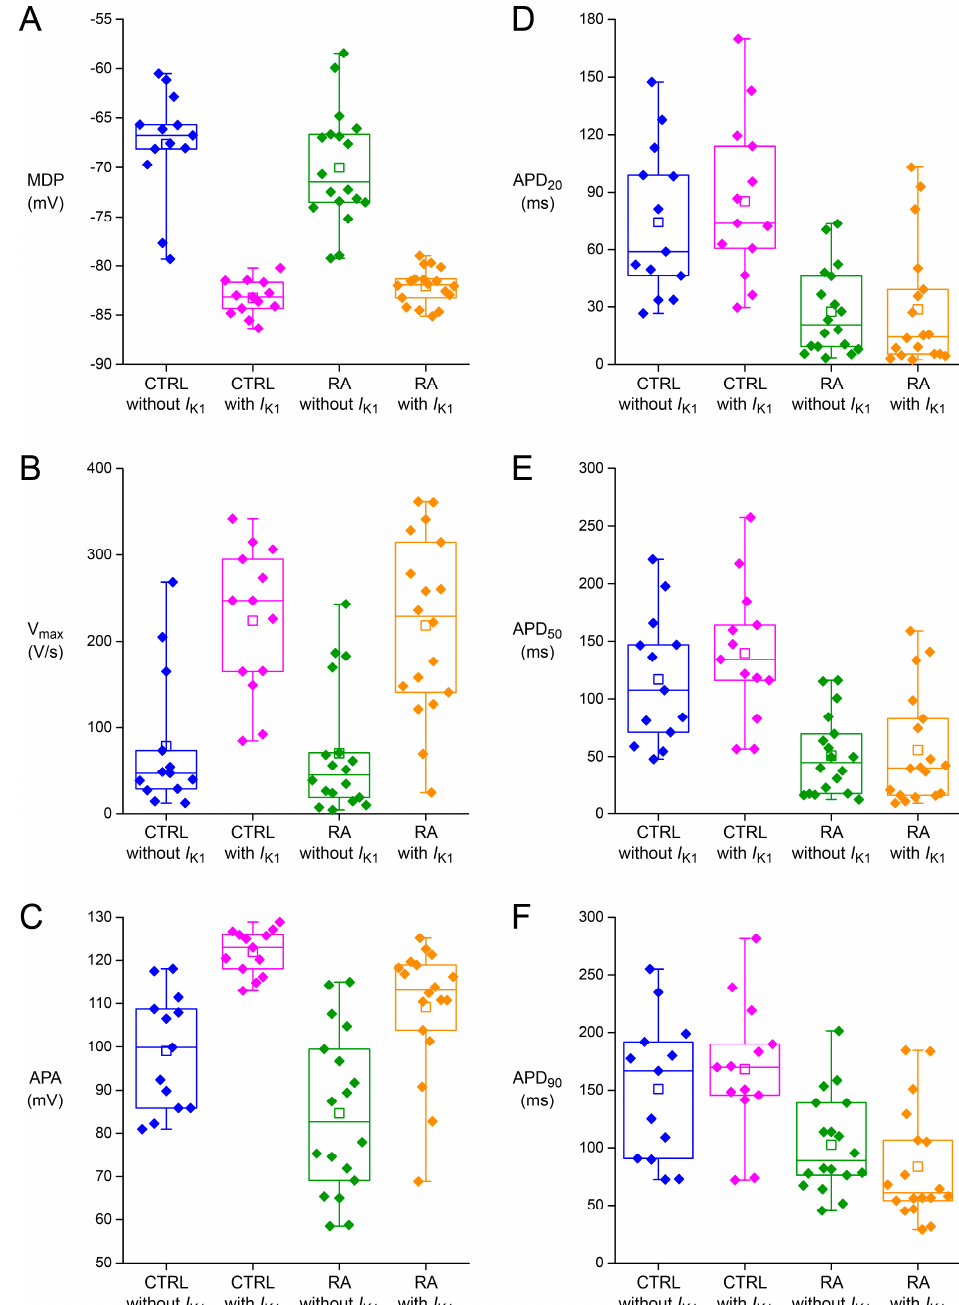
Figure 5. Standard box plots of action potential parameters of all CTRL and RA-treated hiPSC-CMs measured ( n = 13 and n = 18, respectively), both with and without I K1 injection. ( A ) Maximum diastolic potential (MDP). ( B ) Maximum upstroke velocity (V max ). ( C ) Action potential amplitude (APA). ( D ) Action potential duration at 20% repolarisation (APD 20 ). ( E ) Action potential duration at 50% repolarisation (APD 50 ). ( F ) Action potential duration at 90% repolarisation (APD 90 ).